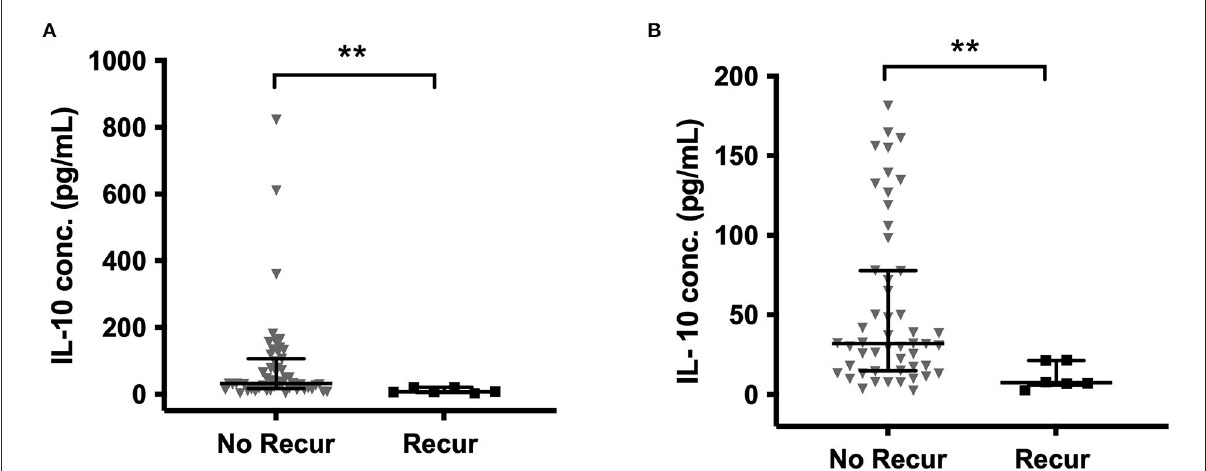
FIGURE5 IL-10 in primary CSDH fluid samples that went on to recur and those that did not recur (A) all data (B) outliers excluded (excluded by interquartile range × 1.5 rule). No recurrence (No Recur) n = 55; Recurrence n = 6. Line (median), bars (IQR), and statistically significant differences are denoted as p ≤ 0.005